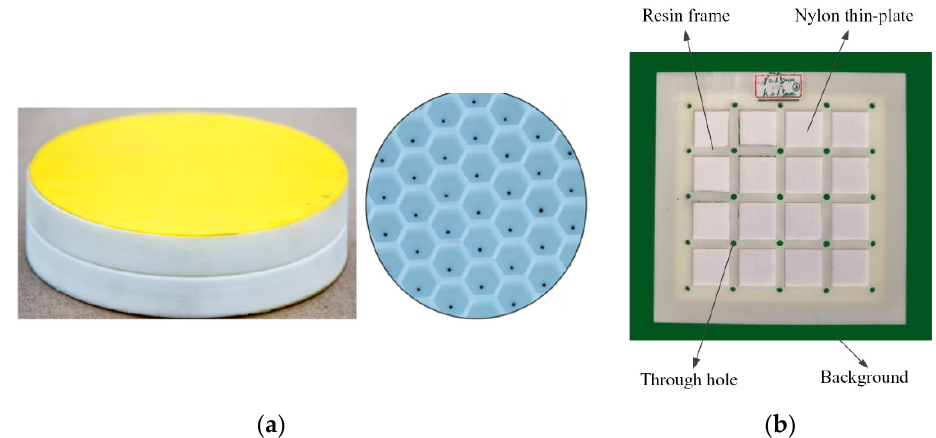
Figure 5. Examples of AMM devices incorporating membranes and perforated plates, where ( a ) displays a uniform metastructure of hexagonal unit-cells arranged in parallel and sealed by membranes at each open end (Reprinted from [71], with the permission of AIP Publishing). ( b ) shows a perforated thin-plate design with holes drilled at the cross points of the resin frame to introduce anti-resonant behaviour [73] (Republished with permission of IOP Publishing Ltd., from [Journal of Physics D: Applied Physics, Y. Xu, et al., Volume 52, Edition No. 40, 2019.]; permission conveyed through Copyright Clearance Center, Inc., Danvers, MA, USA).